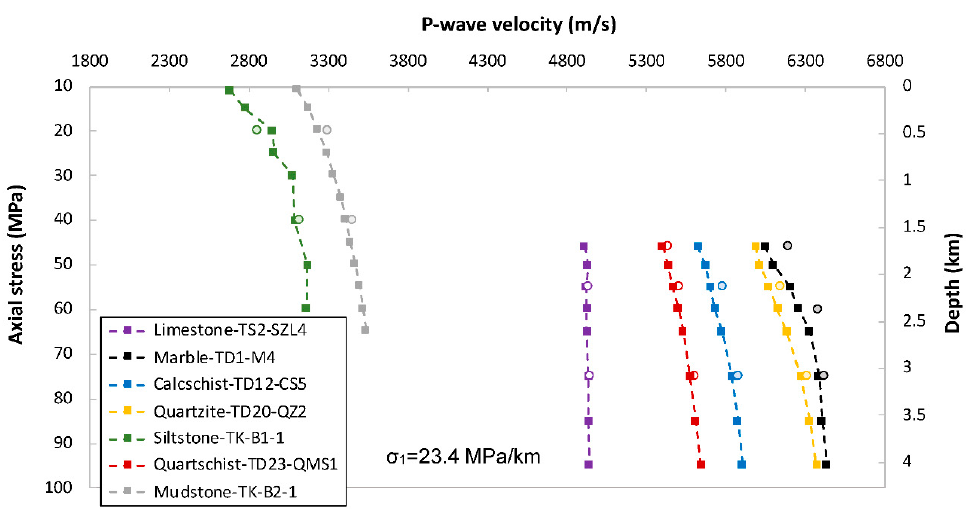
Figure 7. P-wave velocity as a function of axial stress, and thus depth below the surface, for all seven CCS tests conducted within experimental series C. After the samples were loaded until σ 1 = 65 or 95 MPa (dashed lines), unloading took place during which several acoustic measurements were taken to check for potential hysteresis effects (circular data points). Axial stress–depth relationship is taken from [35].